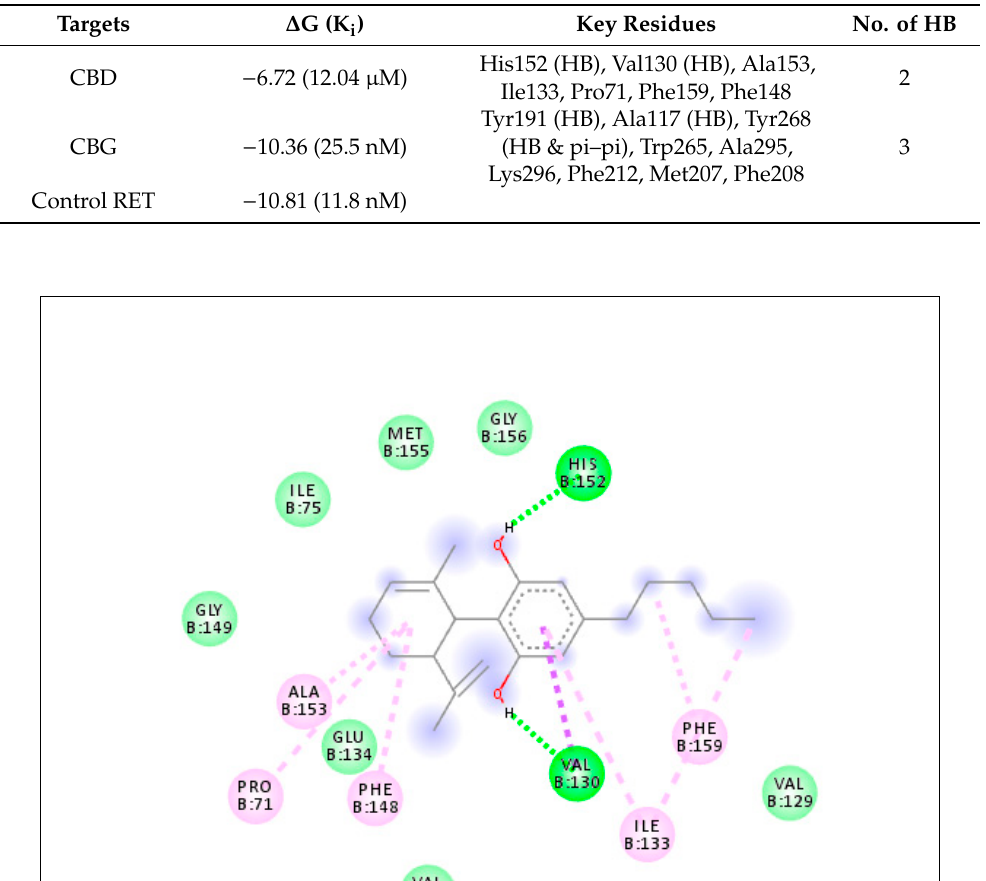
Table 3. The calculated binding free energy, ∆ G, in kcal / mol, the inhibition constant Ki, the key residues and the number of hydrogen atoms of the docked